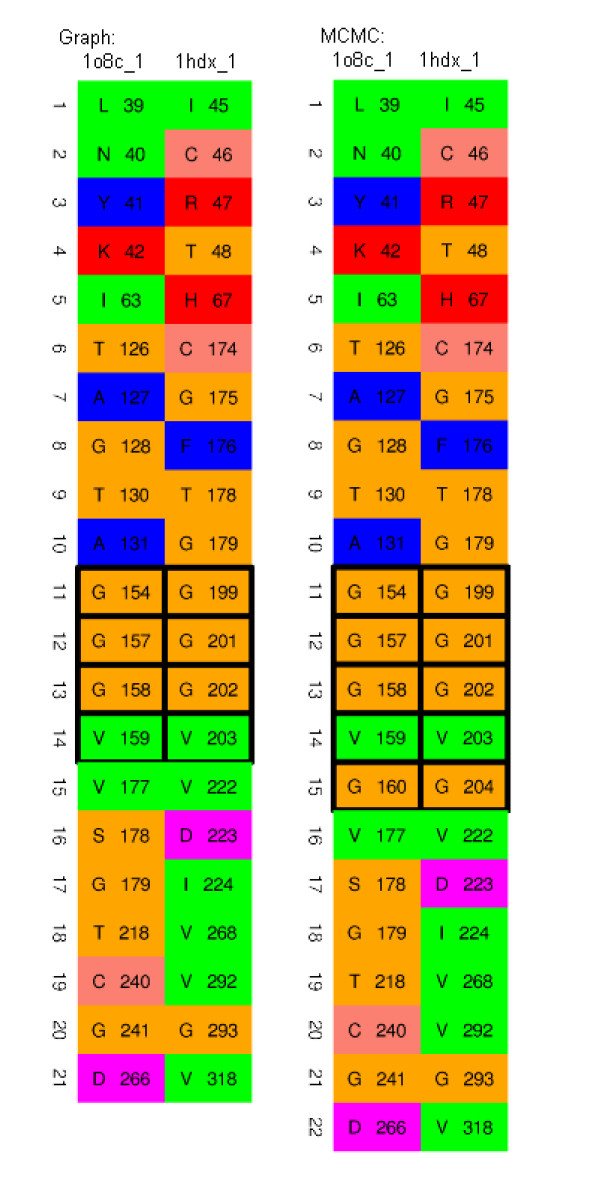
Corresponding amino acids between the NAD-binding site of alcohol dehydrogenase (1hdx_1) and NADP-binding site of hypothetical protein YhdH (1o8c_1) before and after MCMC refinement step with the glycine rich motif highlighted (see main text) (Case 1).